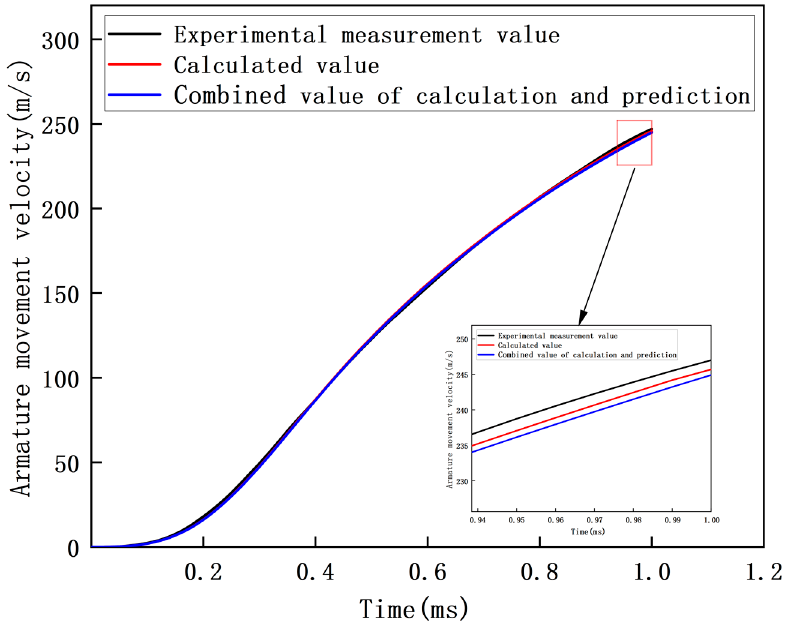
Figure 14. Comparison of armature movement velocity.